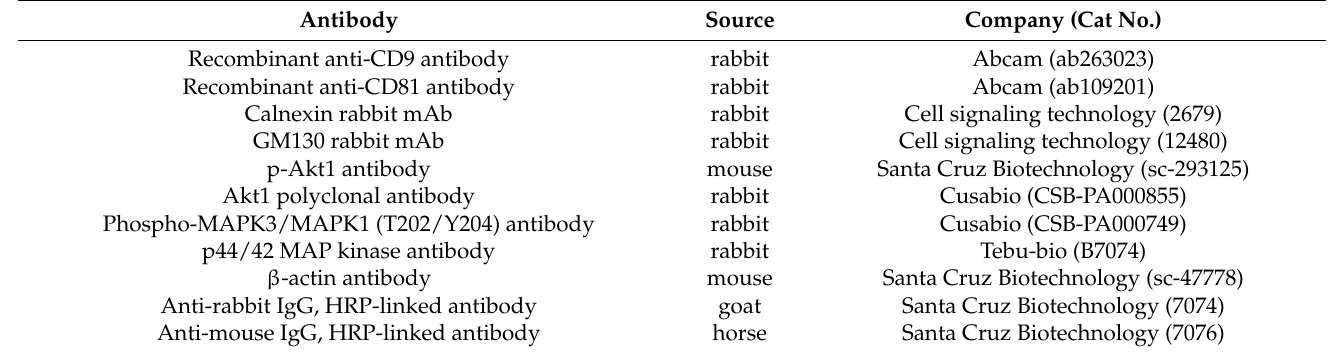
Table 2. List of antibodies for Western